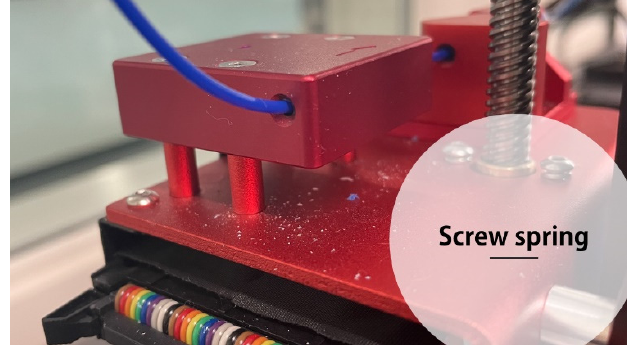
Figure 3. Screw spring that provides tension for the gear feeding process.